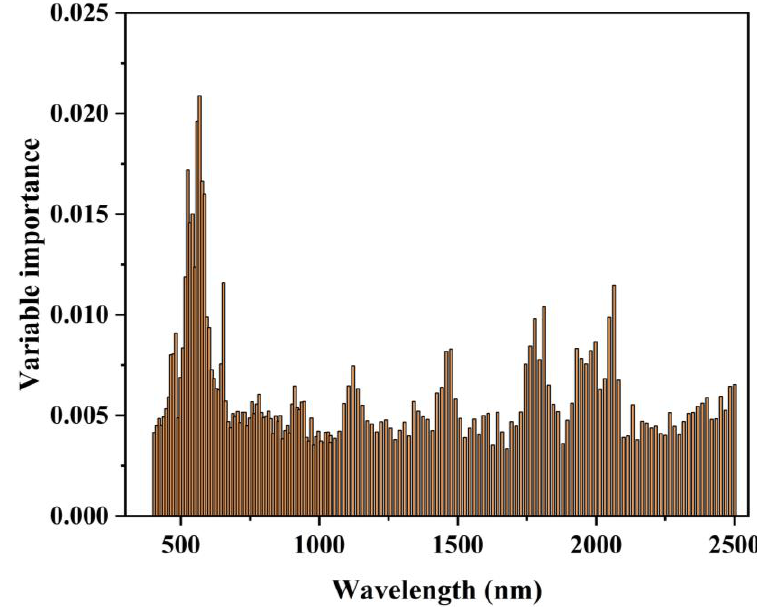
Figure 9. Model predicted contribution importance for RF input variables.